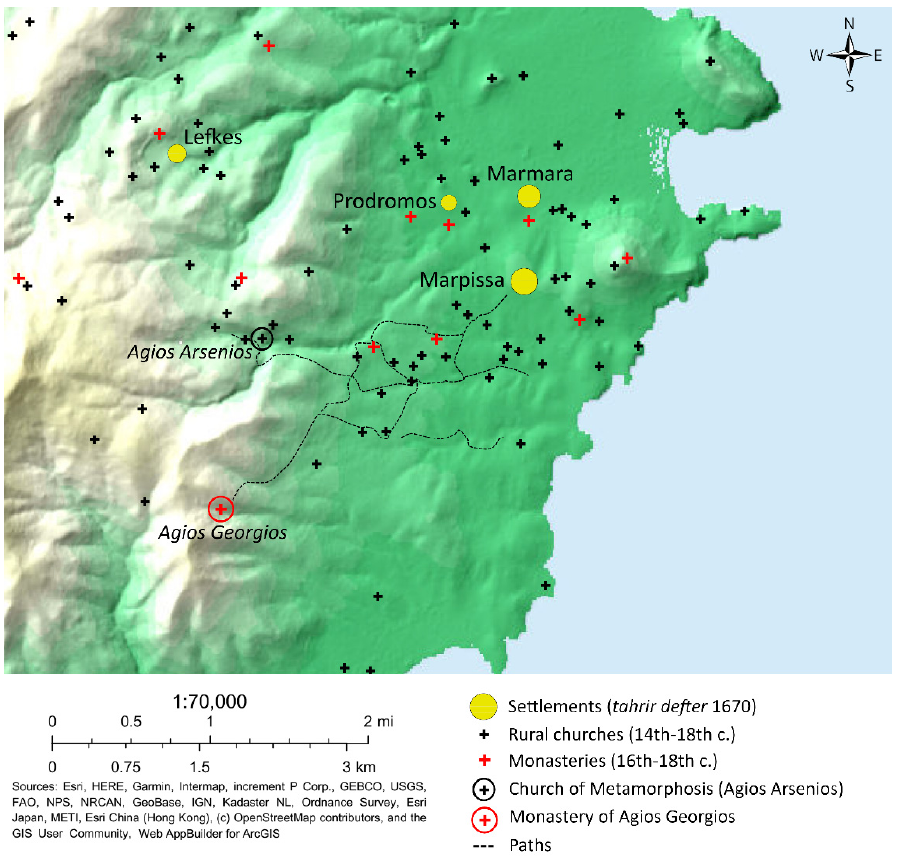
Figure 15. A map of the central east plain of Paros with settlements (yellow dots), monasteries (red crosses), outlying churches (black crosses) and paths (dotted lines) leading to the Monastery of Agios Georgios and the cave-church of the Transfiguration/Agios Arsenios (map by the author).